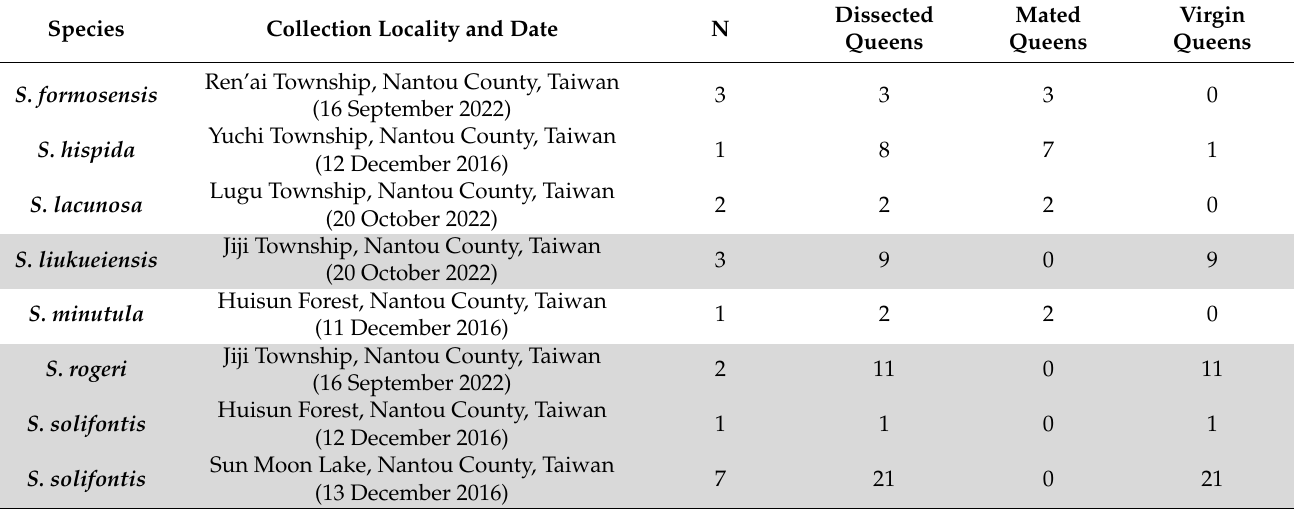
Table 2. Survey of species of which field-collected dealate queens were dissected to determine their insemination status (N = number of colonies). Grey indicates thelytokous species. Species Collection Locality and Date N